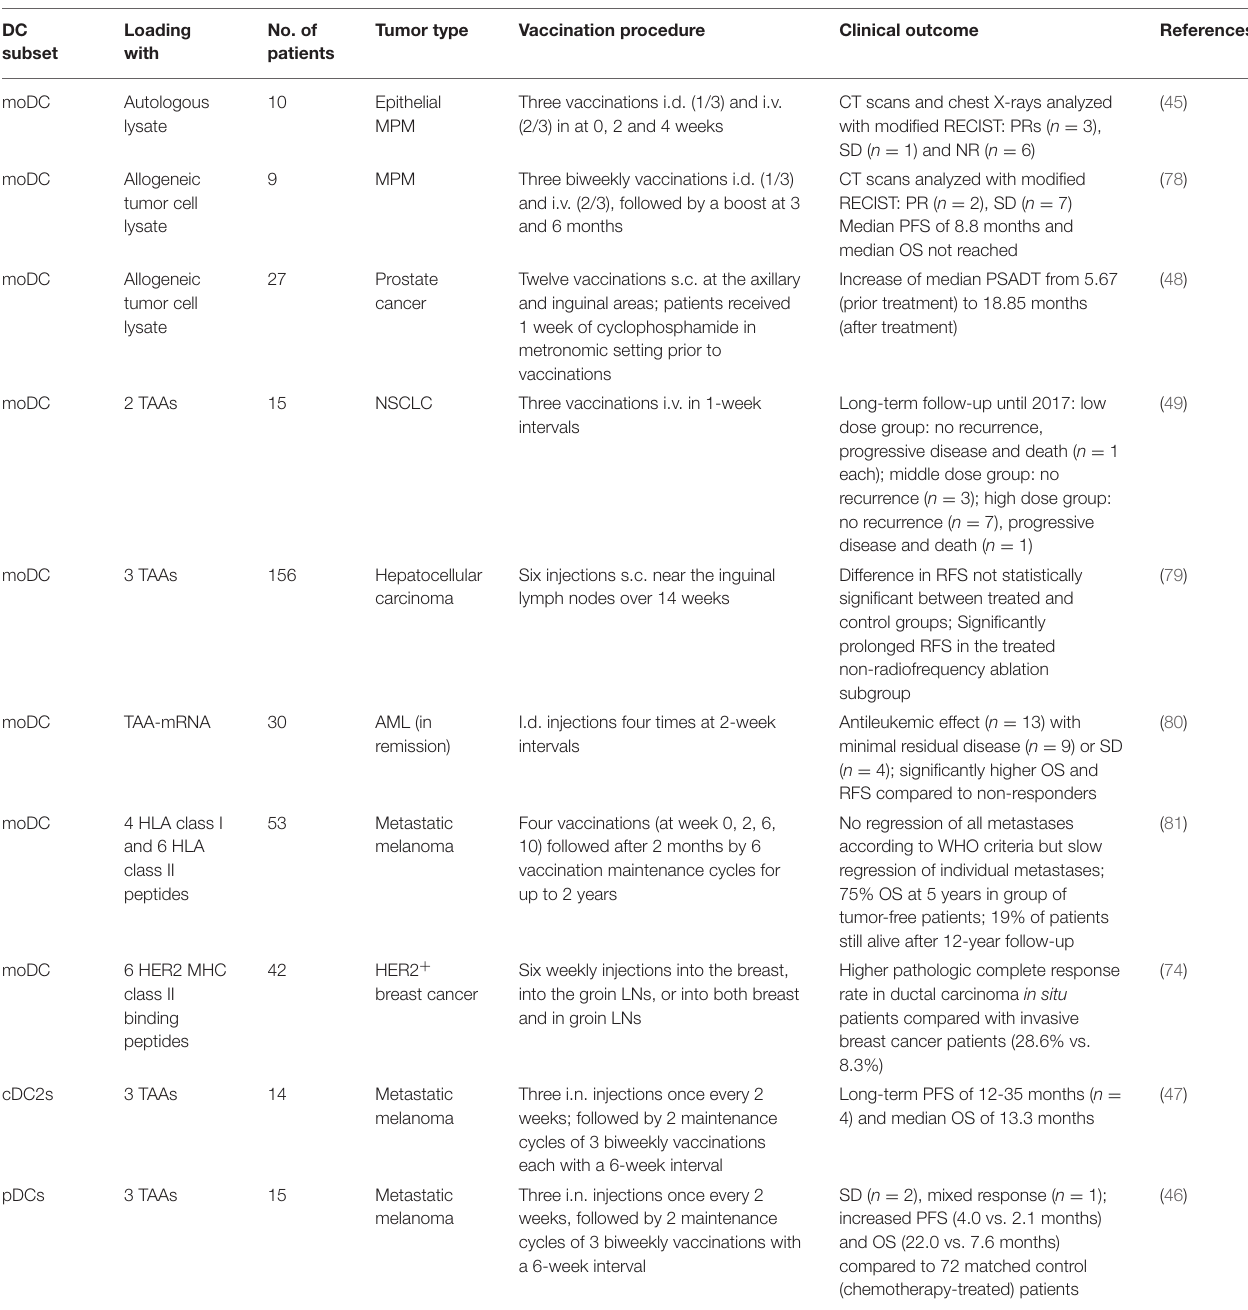
TABLE 1 | Clinical trials employing different DC subsets and different sources of antigens. DC